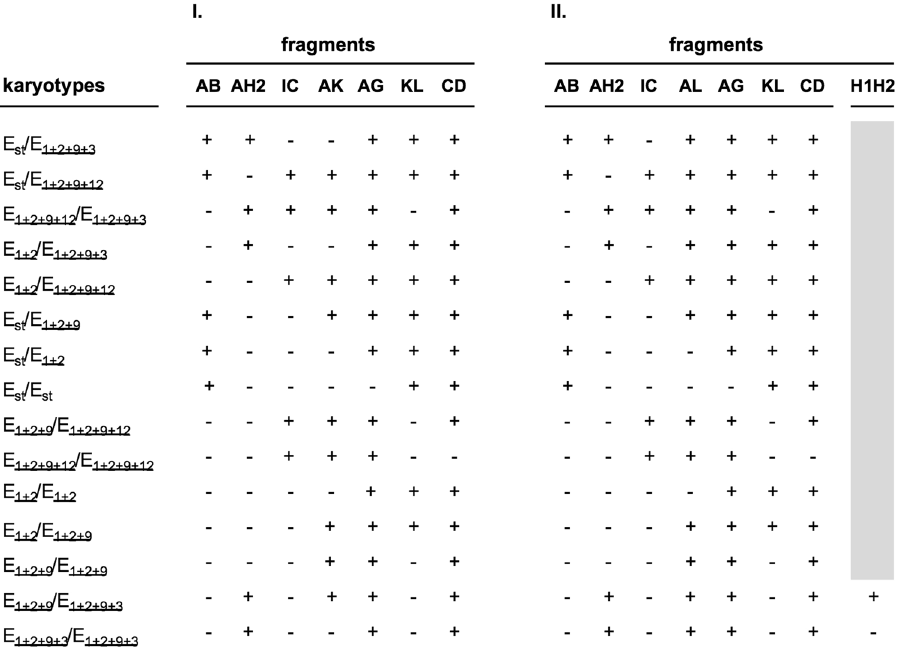
Figure 3. Strategy used to determine each of the 15 possible karyotypes for chromosomal arrangements E st , E 1 + 2 , E 1 + 2 + 9 , E 1 + 2 + 9 + 3 and E 1 + 2 + 9 + 12 . (I) Initial one-round strategy consisting in the PCR amplification of seven fragments. (II) Final two-rounds strategy consisting in a first round of seven PCR amplifications, and a second conditional round of a single amplification. + and − , expected and not expected fragment amplification,